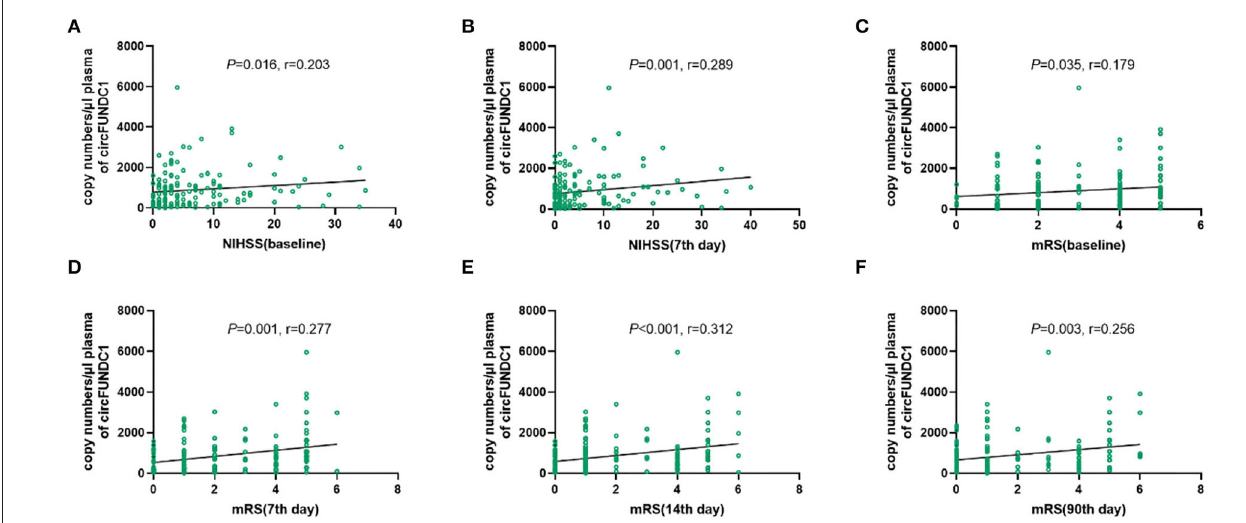
FIGURE 7 | The relationship between NIHSS scores, mRS scores, and expression of circFUNDC1 in acute ischemic stroke (AIS) patients within 24h after onset. The scatterplot showed circFUNDC1 levels were positively associated with baseline NIHSS scores (A) , the 7th day NIHSS scores (B) , baseline mRS scores (C) , the 7th